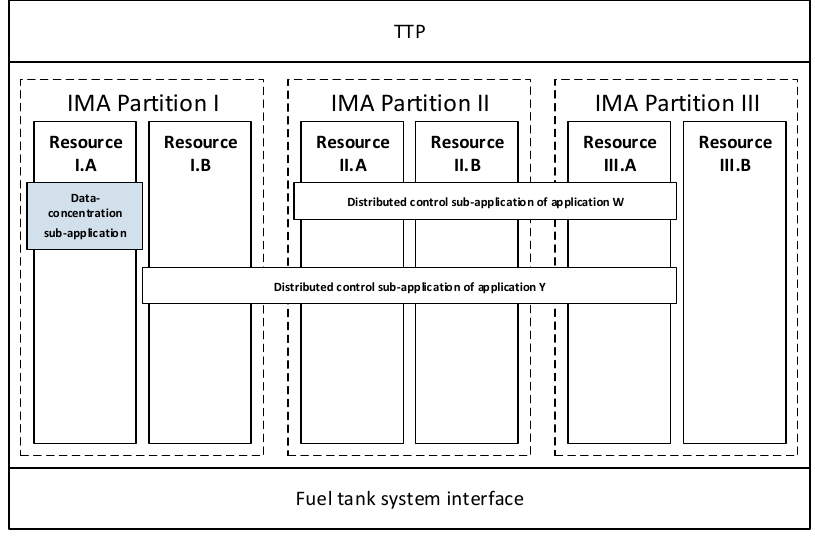
Figure 7. Central Processor Input/Output Module (CPIOM)-Sensing device.